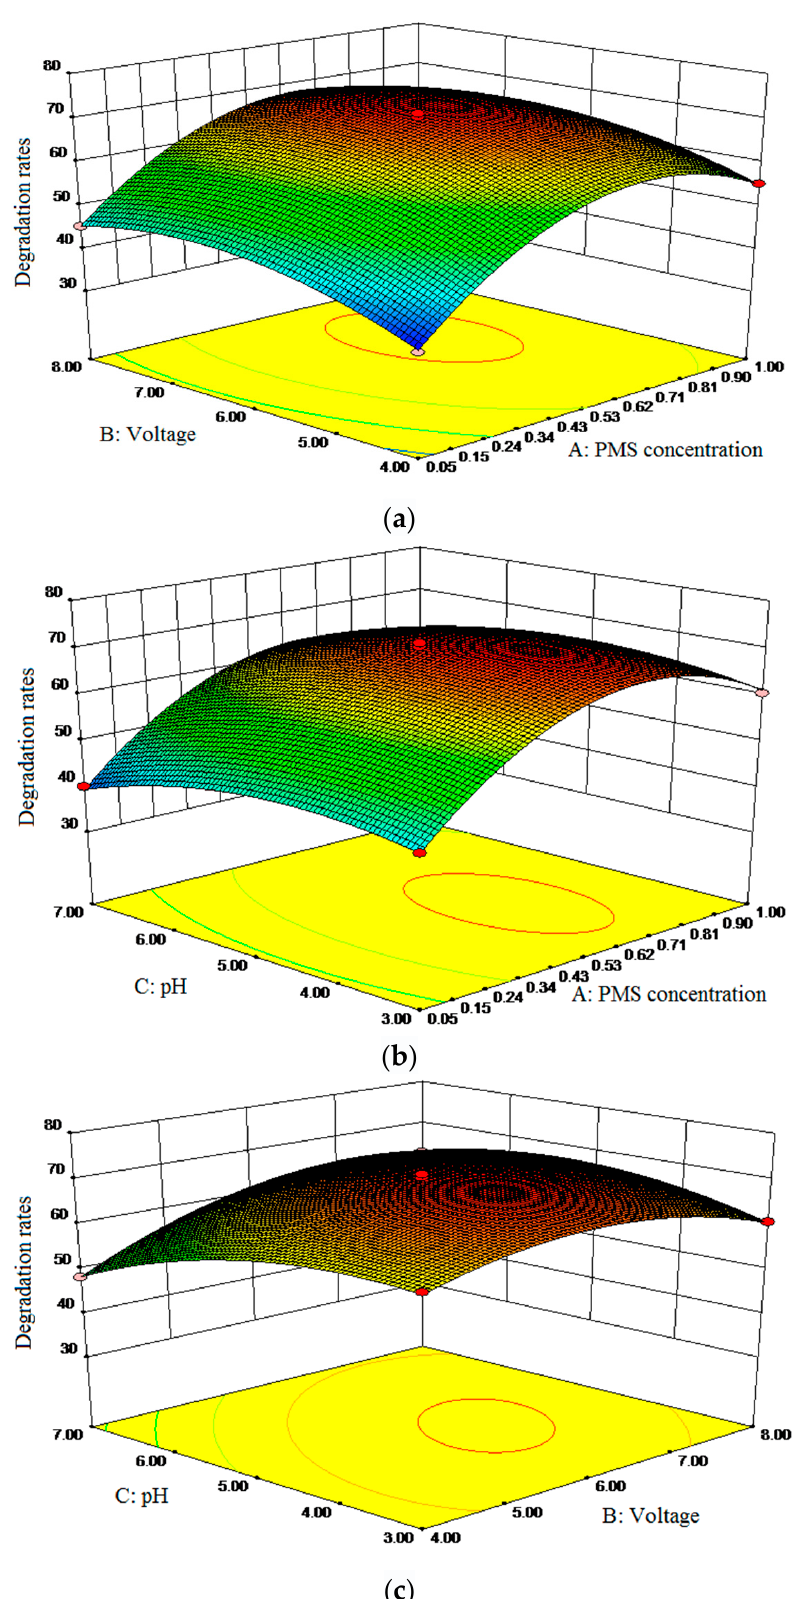
Figure 2. Interaction effect of single parameters on the degradation rate of CIP. ( a ) PMS concentration and voltage; ( b ) PMS concentration and pH; ( c ) pH and voltage.